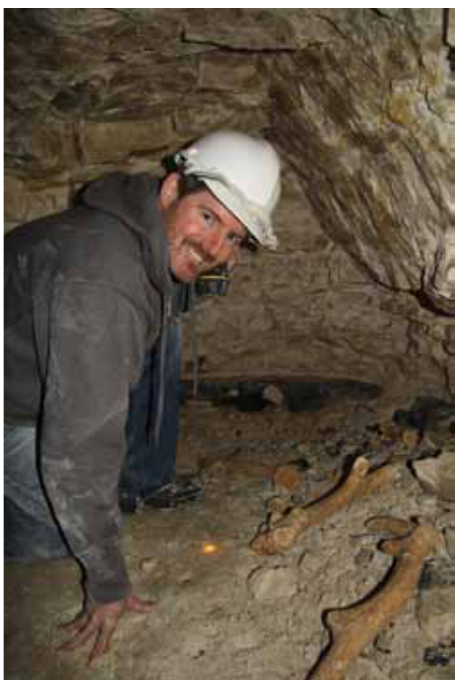
Fig. 2: Kevan Edinborough, one of the pro- ject postdocs, at the bottom of one of the Grimes Graves flint mine pits (photo Tim